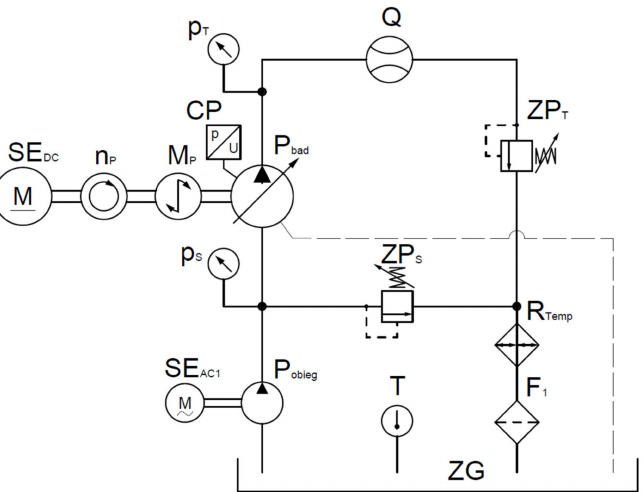
Figure 8. Test stand hydraulic scheme: P bad —tested pump; P obieg —preliminary pump; P wir — auxiliary pump; SE—electric motors; ZP—pressure relief valves; ZG—main tank; R Temp —heat exchanger; F—filters; n p —tachometer; M p —torque meter; p—manometers; CP—internal pressure sensor; T—temperature sensor; Q—flow